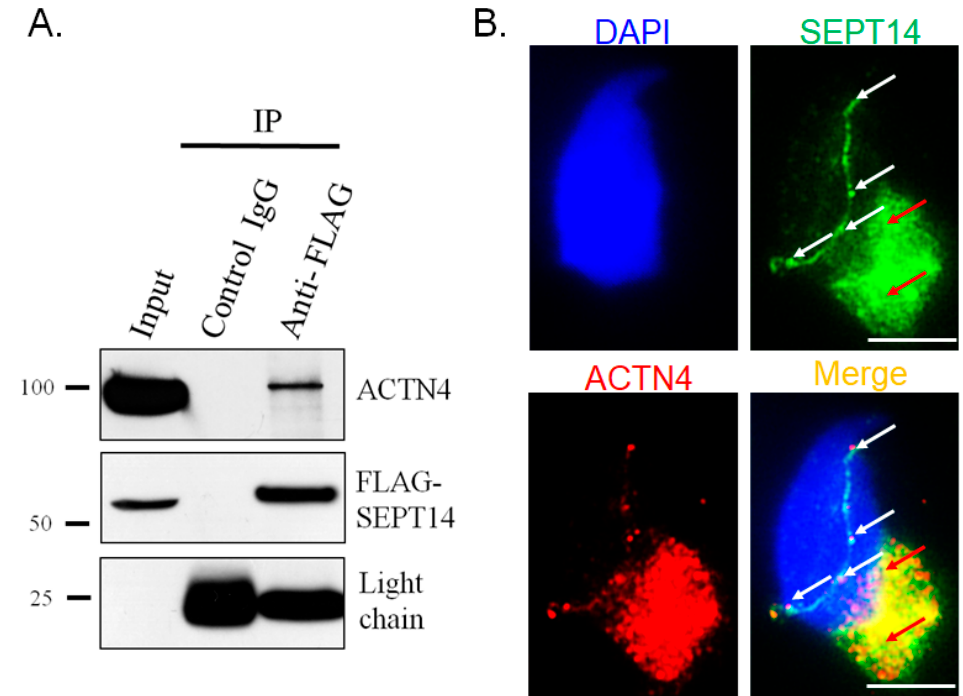
Figure 3. SEPT14 interacts with ACTN4 in male germ cells. ( A ) Co-IP of FLAG-SEPT14 with ACTN4. Lysates from cells transfected with a pFLAG-SEPT14 vector were immunoprecipitated with either a nonspecific control IgG (Lane 2) or FLAG antibody (Lane 3), followed by immunoblotting with an ACTN4 or FLAG antibody. Light chain was used as a loading control. Input protein (5%) was used as an immunoblotting control (Input). ( B ) SEPT14 was co-localized with ACTN4 in murine spermatids. DAPI staining (blue), SEPT14 (green), ACTN4 (red), and a merged image of the DAPI, SEP14, and ACTN4 signals in murine spermatids are shown. SEPT14 signals are near the perinucleus rim (white arrows) and manchette structure (red arrows). More than 10 elongating spermatids have been stained. Magnification, 1000×. Scale Bar: 10 μ M.